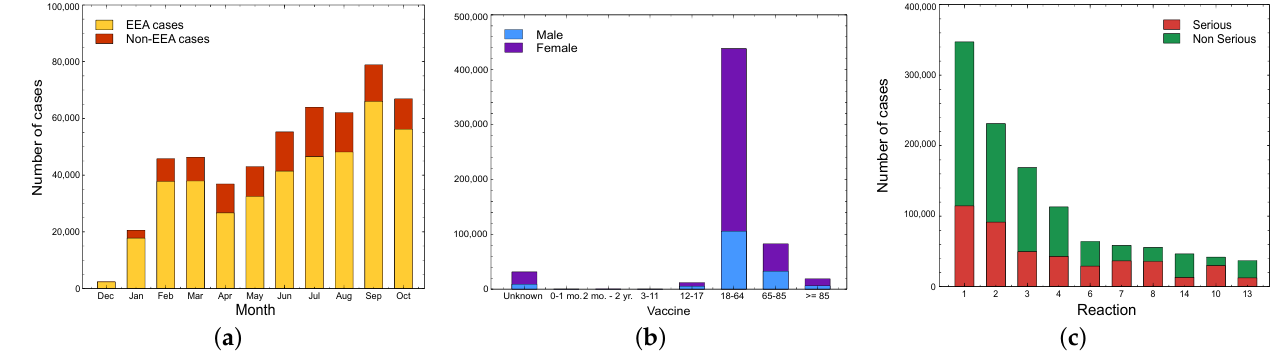
Figure 2. Main results of pharmacovigilance for Comirnaty vaccine: number of reports received over time ( a ), and their distribution by age group and sex ( b ) and by seriousness ( c ).